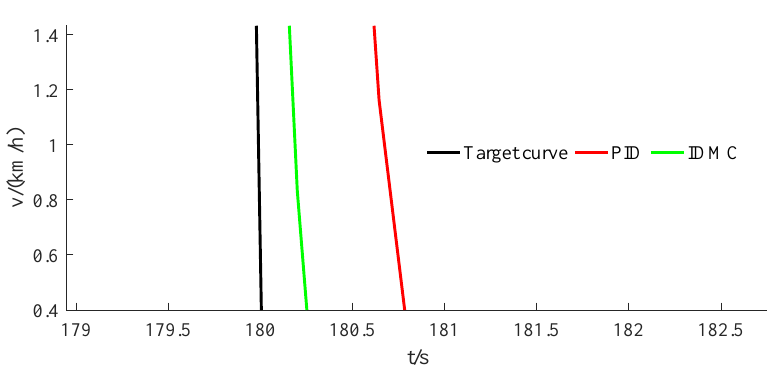
Figure 21. The elliptic region 3 in Figure